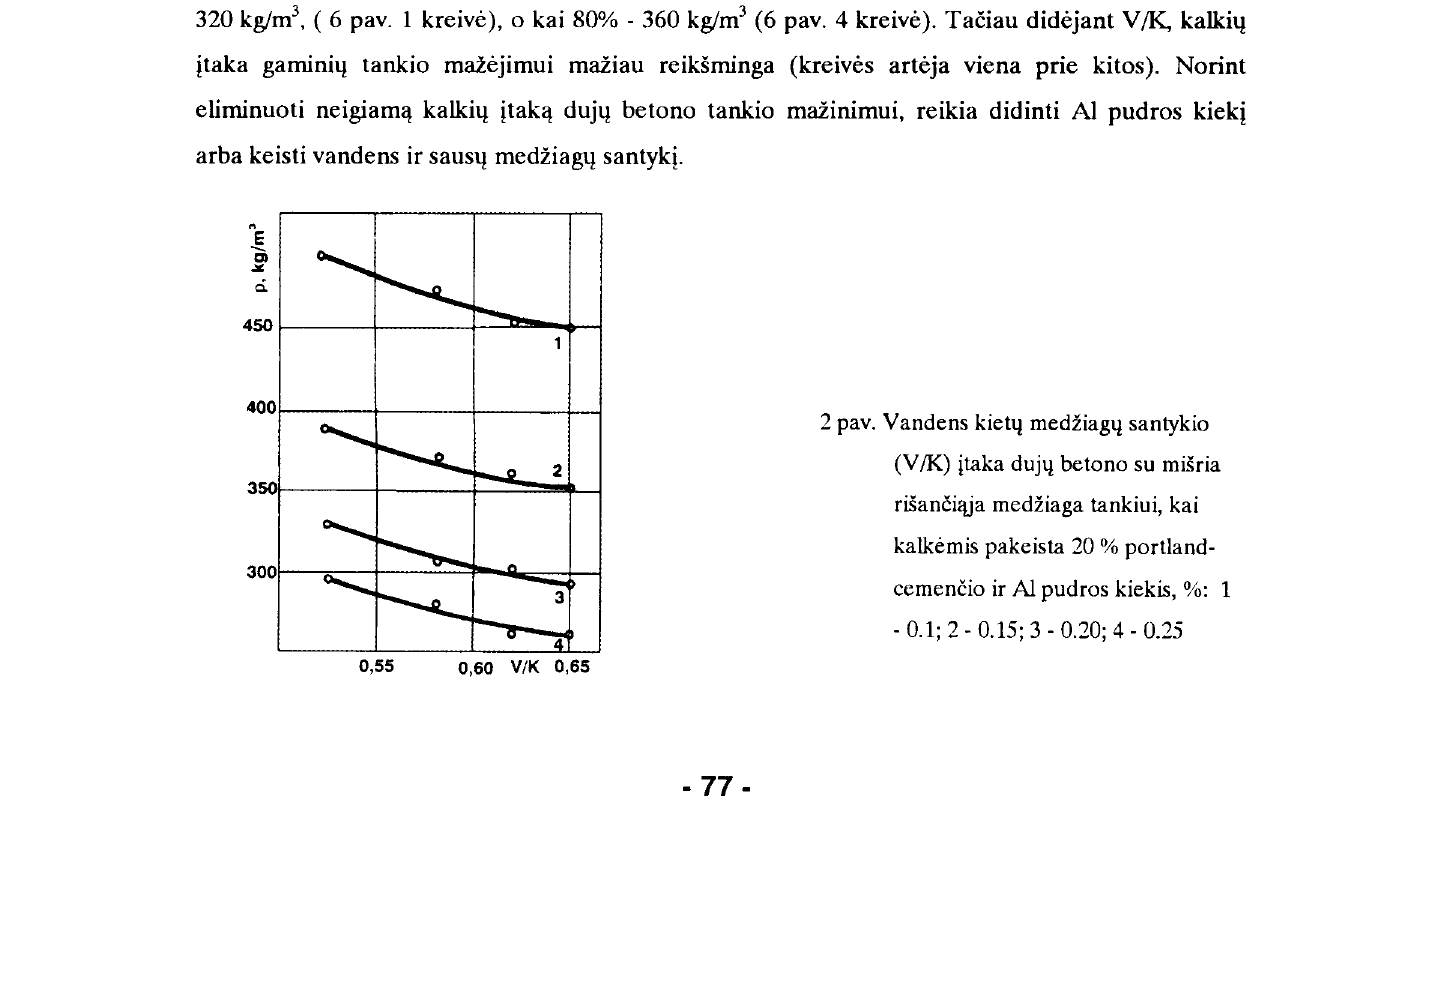
Nuo kalki4 kiekio rniSrioje risanCioje med:liagoje priklauso AI pudros panaudojimo efektyvumas. Kaip matyti is 2 - 5 pav., naudojant daugiau AI pudros, gaunamas ma:lesnio tankio duj4 betonas. Didinant kalki4 kiekj rnisrioje risanCioje medziagoje duj4 betono tankis dideja (6 pav. ). Pvz., kai V /K 0,55 garnini4, kuriuose 20 % portlandcemenCio pakeista kalkernis, tankis yra